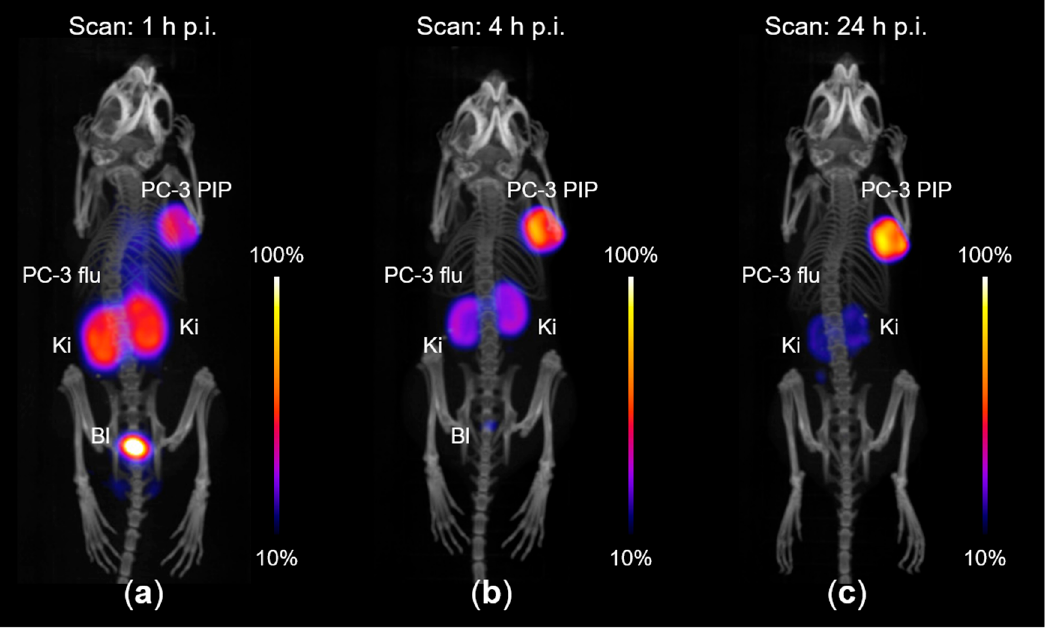
Figure 8. PET/CT images acquired with PC-3 PIP/flu tumor-bearing nude mice after intravenous injection of [ 44 Sc]Sc-PSMA-ALB-02 (~5 MBq, 1 nmol per mouse). The PET/CT images are shown as maximum intensity projections (MIPs) with the scale adapted for each time point to make tumors and kidneys visible. ( a ) PET/CT scan obtained 1 h p.i. of the radioligand; ( b ) PET/CT scan obtained 4 h p.i. of the radioligand; ( c ) PET/CT scan obtained 24 h p.i. of the radioligand. PC-3 PIP = PSMA-positive tumor xenograft on the right shoulder; PC-3 flu = PSMA-negative tumor xenograft on the left shoulder; Ki = kidney; Bl = bladder .